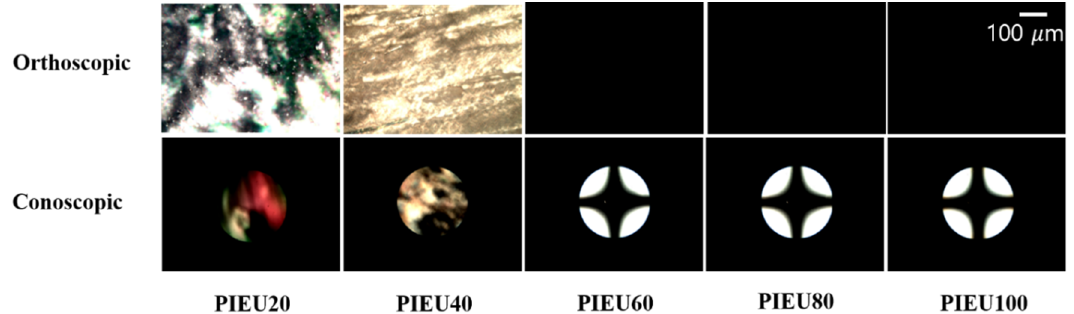
Figure 6. Orthoscopic and conoscopic polarized optical microscopy images of the LC cells made from PIEU# (PIEU20, PIEU40, PIEU60, PIEU80, and PIEU100) films.